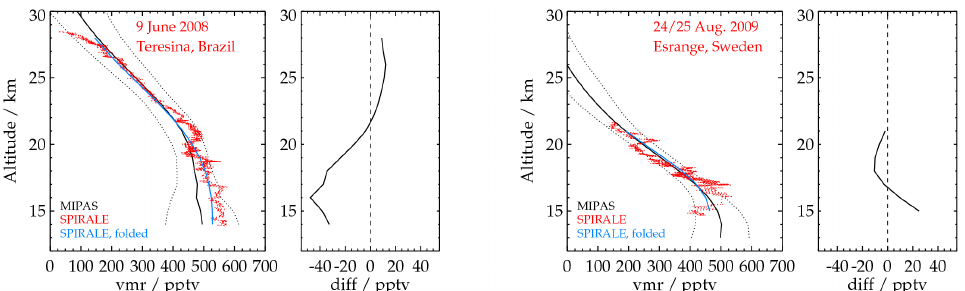
Figure 4. Comparison of MIPAS OCS data (black) with OCS balloon profiles obtained by the SPIRALE experiment (red) on 9 June 2008 over Teresina, Brazil (5.1 ◦ S, 42.1 ◦ W, left), and on 24–25 August 2009 over Esrange, Sweden (67.9 ◦ N, 21.1 ◦ E, right). The displayed MIPAS data are averages, for which all profiles within a radius of 1000km and a temporal offset of 24 hours with respect to the SPIRALE profiles were taken into account. The dotted lines indicate the standard deviation of the MIPAS profiles, and the blue curves are the SPIRALE profiles convolved with MIPAS averaging kernels.